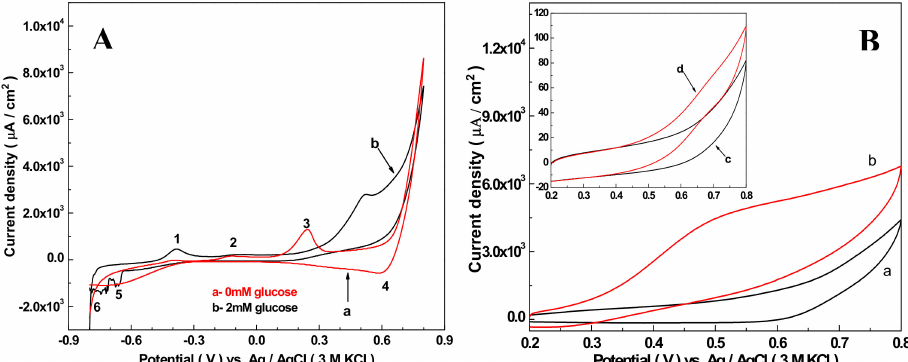
Figure 2. ( A ) Redox peaks of the present Nafion / Cu 2 O–BSA / GCE in the 50 mM NaOH solution with 0 (a) and 2 mM (b) of glucose at the scan rate of 5 mV / s, ( B ) Nafion / Cu 2 O–BSA / GCE and Nafion / GCE (inset) in the absence (a and c) and presence (b and d) of 5.0 mM glucose at the same pH with scanning speed of 50 mV /